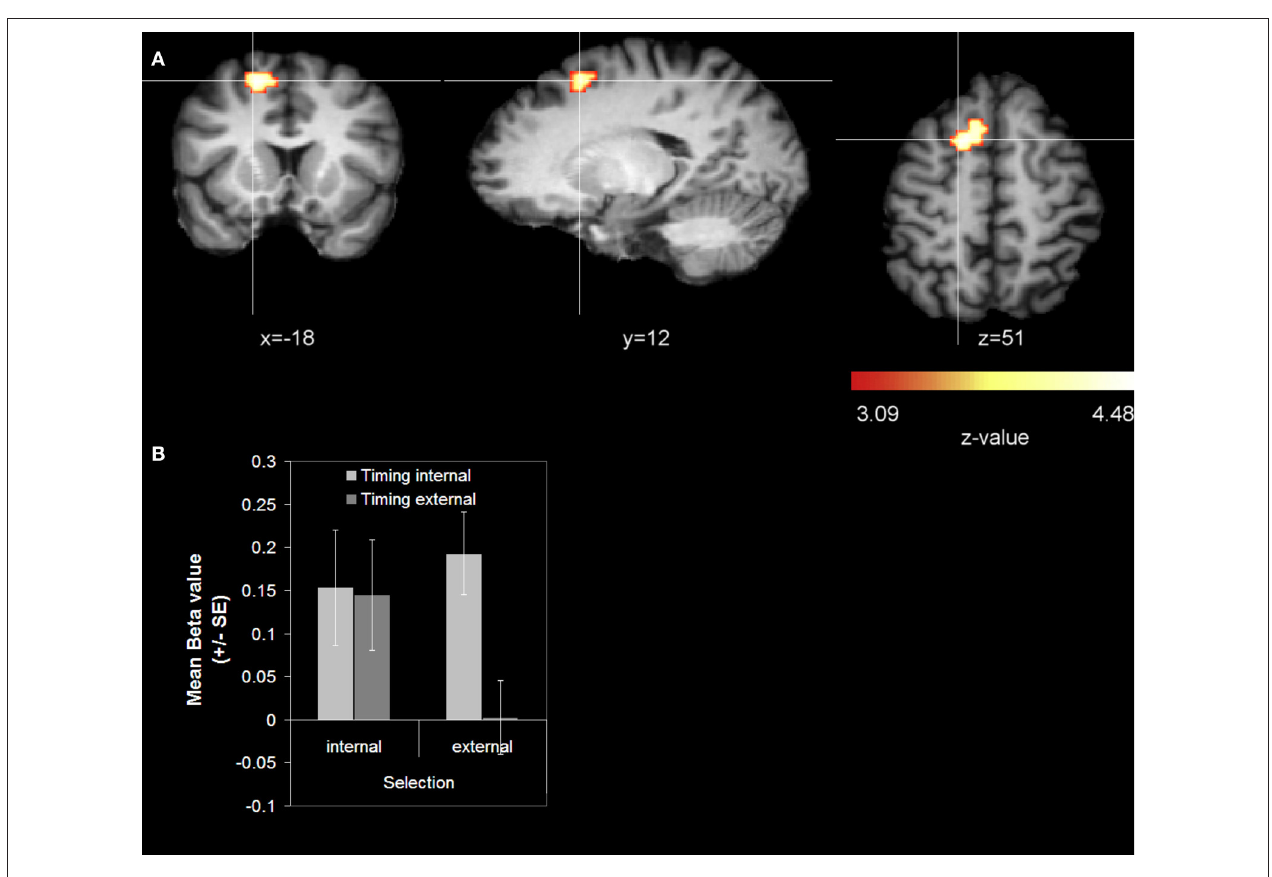
comparison internal action timing > external action timing is shown. (B) Signal strength analysis. The diagram reports mean beta values for the SFG coordinate ( x = − 18, y = 12, z = 51).